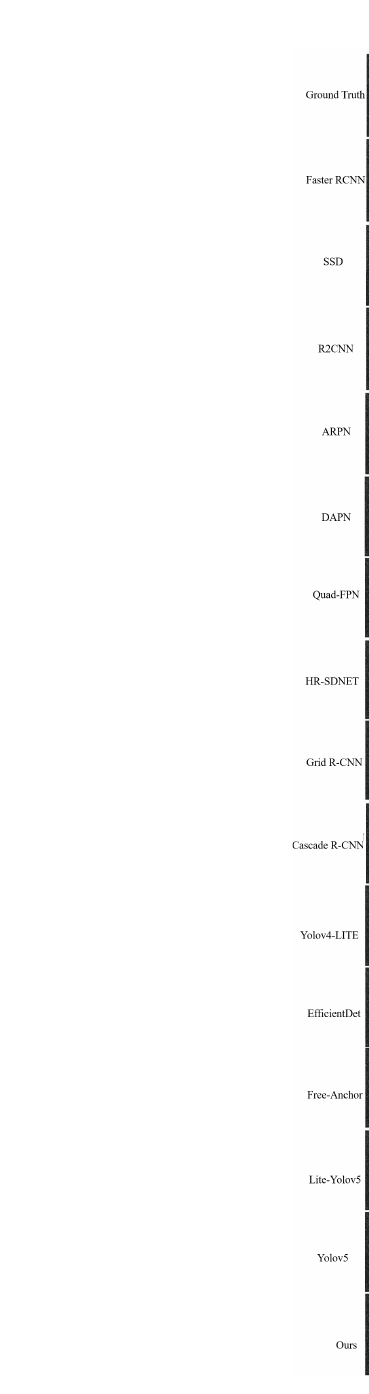
FIGURE 12 The visual detection outcomes of CNN-based approaches for offshore and inshore ships based on AirSARship Dataset. Results from (A) is ground truth, results from (B) is Faster-R-CNN method, results from (C) SSD method, results from (D) is R2CNN method, results from (E) is ARPN, results from (F) is DAPN, results from (G) is Quad-FPN, results from (H) is HR-SDNet, results from (I) is Grid R-CNN, results from (J) is Cascade R-CNN, results from (K) is YOLOv4-LITE, results from (L) is Ef fi cientDet, results from (M) is Free-Anchor, results from (N) is Lite-Yolov5, results from (O) is yolov5-X, and results from (P) is our proposed method. Note the pink circle show the false detection of ship and red circle is show the missing